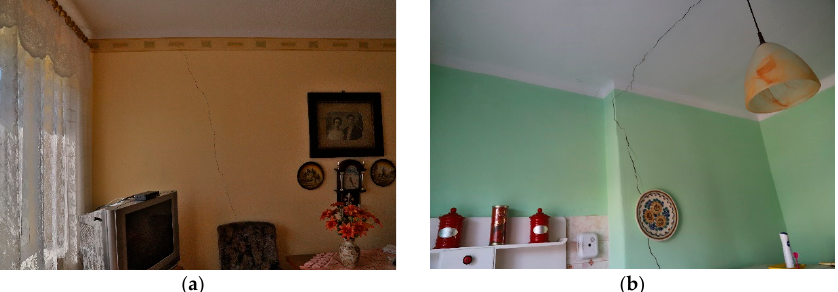
Figure 6. Damage inside the building: ( a ) a fissure in the wall of the living room in the south-east part of the building; ( b ) a crack in the wall and ceiling in the kitchen in the north-east part of the building.